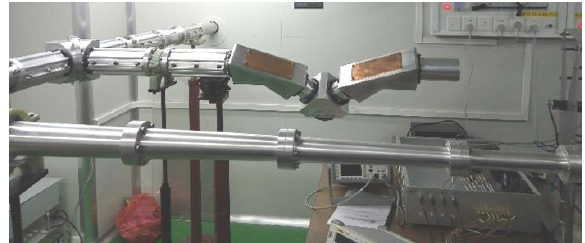
Fig. 11 . Polarization rotators for ECE diagnostic at